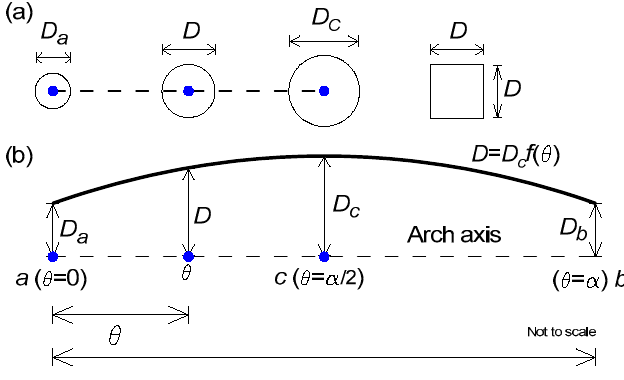
Figure 3. ( a ) Cross-sectional shape of arch and ( b ) variation function of depth (cid:1830) .